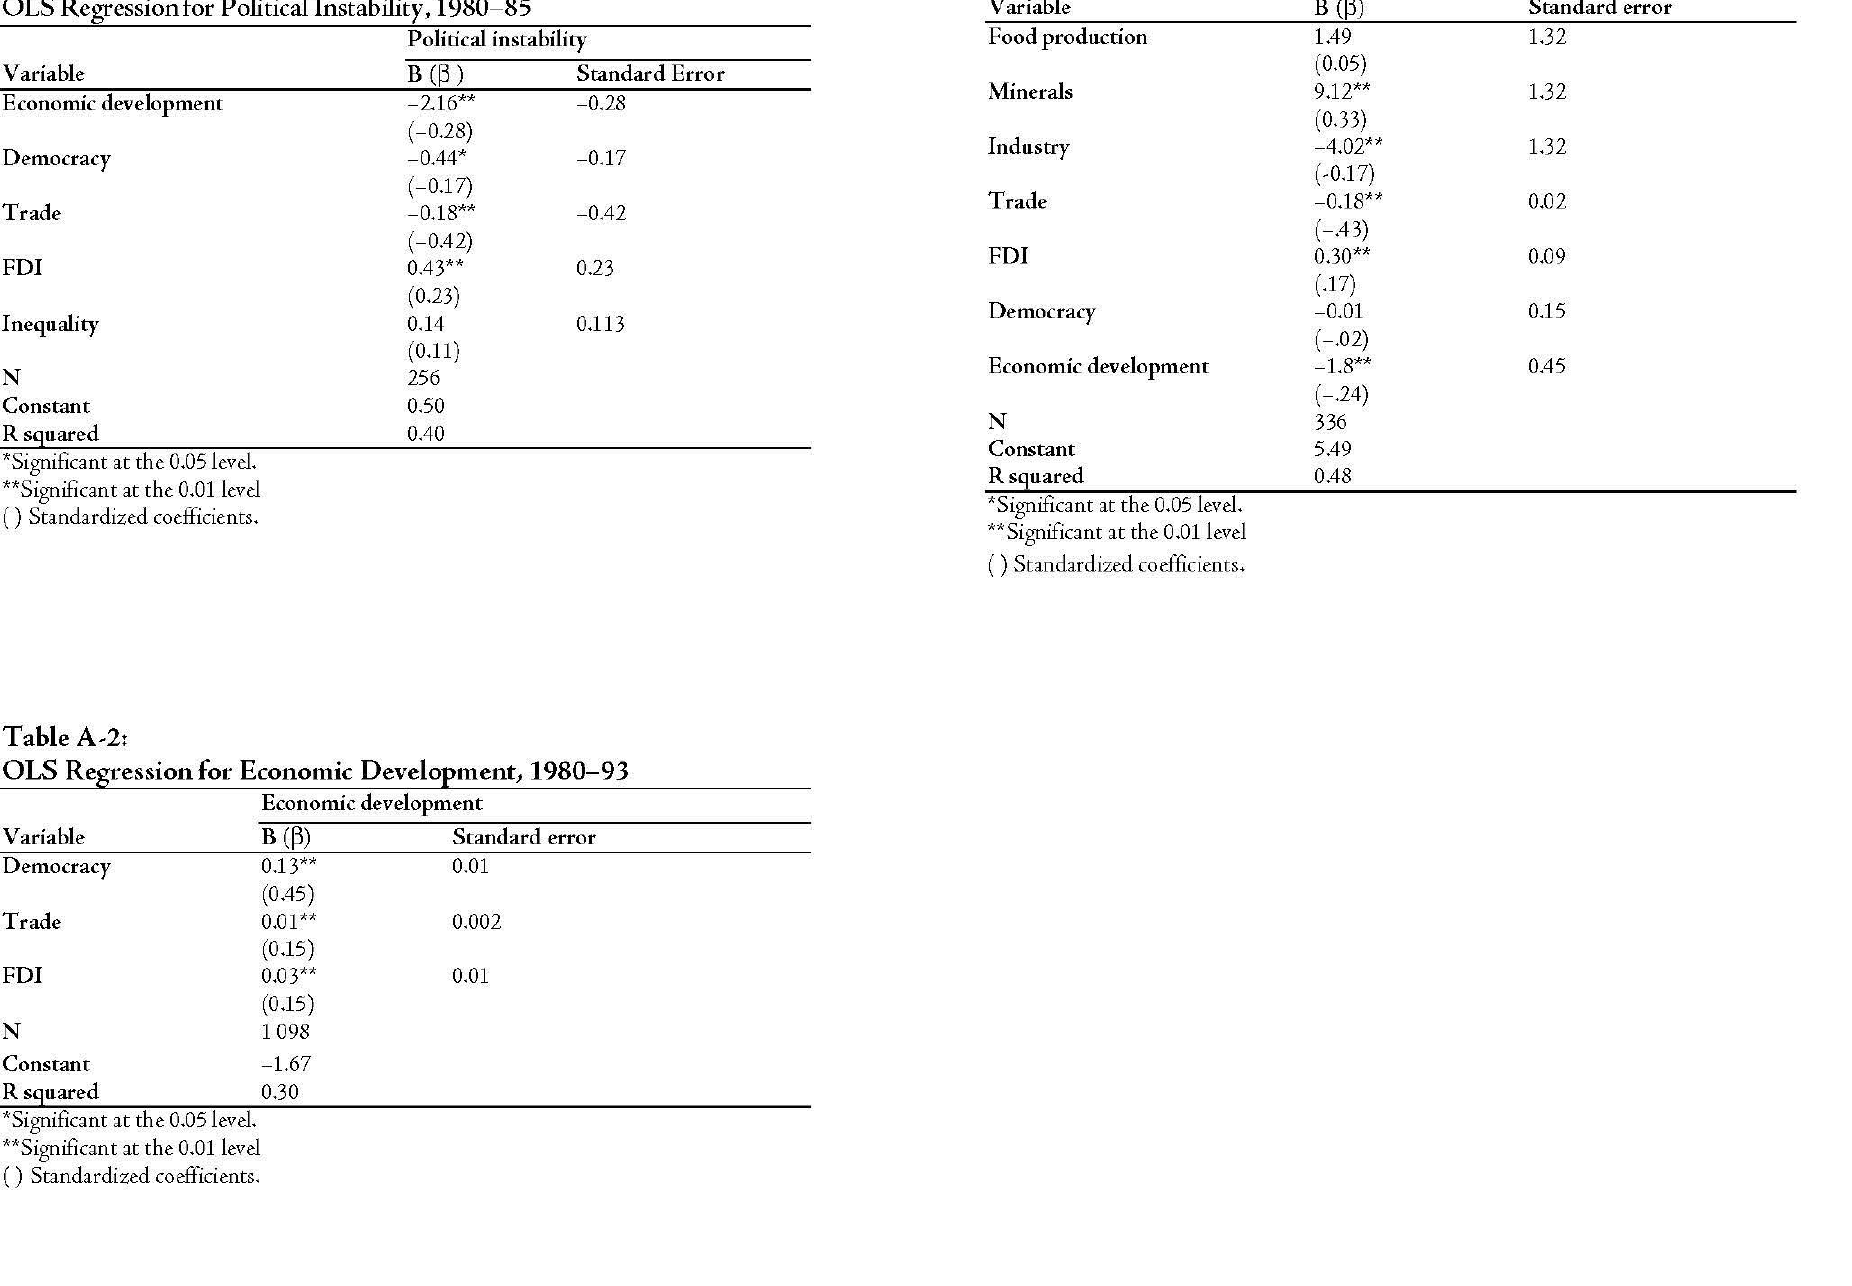
OLS Regression for Economic Development, 1980-93